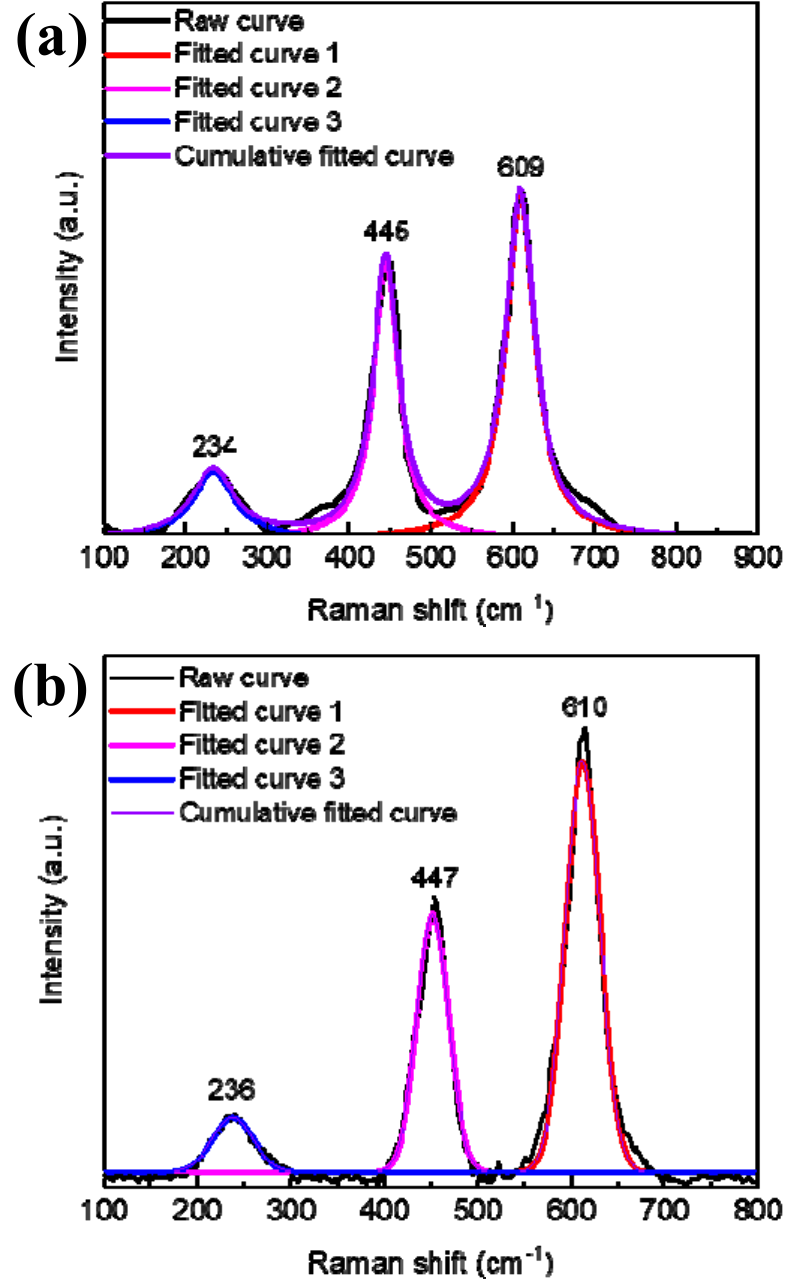
Figure 5. Raman spectra and peak fitting curves of 0.2 mol / L Fe 3 + doped TiO 2 NTAs before ( a ) and after ( b ) photocatalytic experiments.